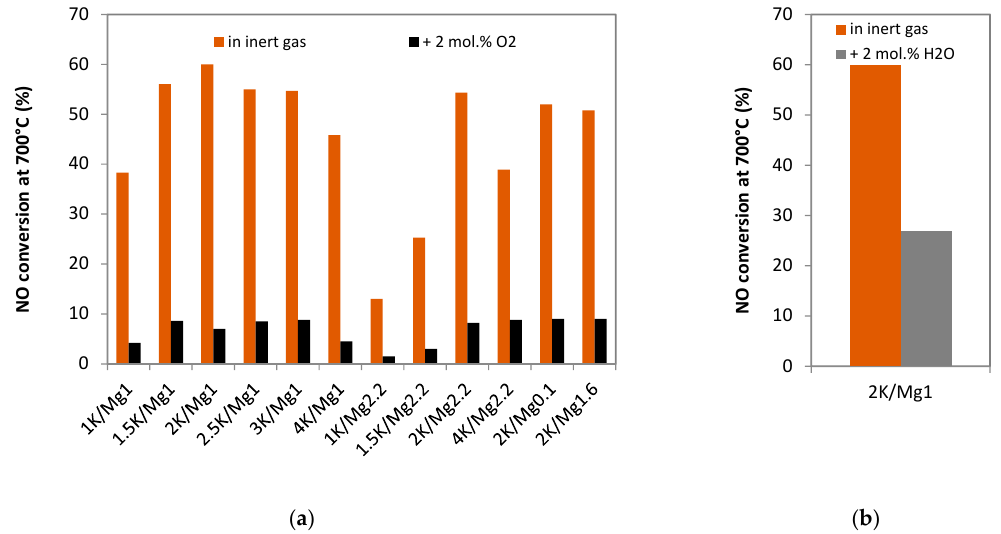
Figure 12. Dependence of NO decomposition over: ( a ) the a K / Mg i group of catalysts in inert and oxygen atmosphere and ( b ) the 2K / Mg1 catalyst in inert and wet atmosphere. Conditions: 1000 ppm NO balanced by N 2 or 1000 ppm NO + 2 mol. % O 2 balanced by N 2 or 1000 ppm NO + 2 mol. % H 2 O balanced by N 2 and GHSV = 6 L g − 1 h − 1 .